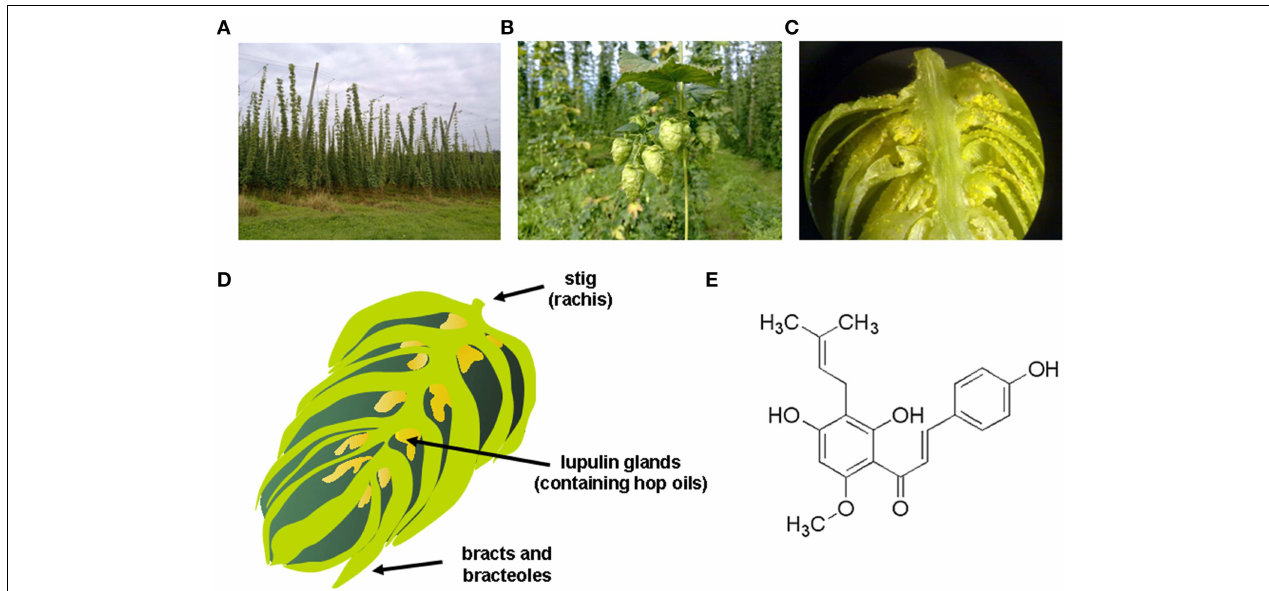
FIGURE 1 | Hop plant and xanthohumol. (A) Hop plant ( Humulus lupulus ) field in Bavaria, showing the typical form of cultivation on high trolleys. (B) Female hop flowers (hop cones), where the biologically active substances, which are also important for brewing, are concentrated inside in the lupulin glands; (C) lupulin glands, which contain hop resins, bitter acids, essential oils and prenylated flavonoids. (D) Schematic drawing of a female hop cone that is composed of a